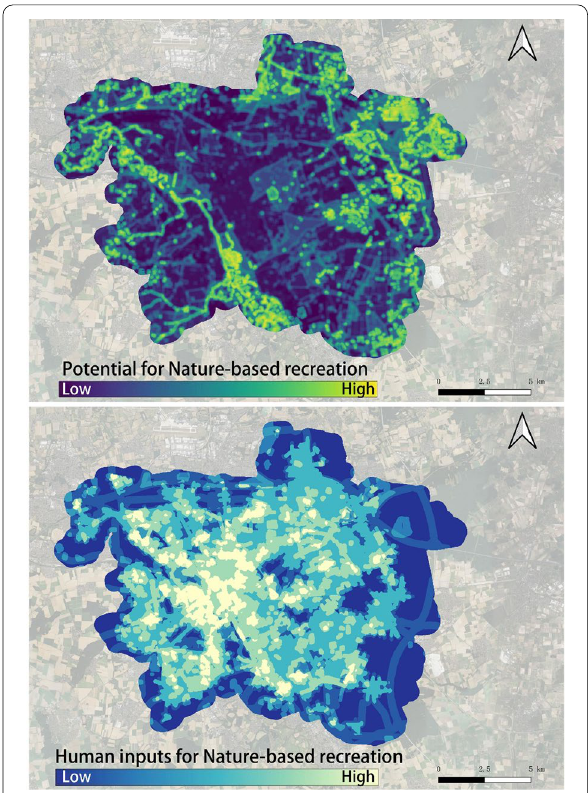
Fig. 6 NBR potential and human inputs for elderly people. The top subgraph shows the NBR potential. The value is normalized to the 0–1 range, where 0 indicates the lowest potential and 1 the highest potential. The bottom subgraph shows the human-input value, which is ranked based on a cross-tabulation of the facility- and proximity-related inputs. The colour ramp shows the range from the lowest (dark) to the highest (light) human